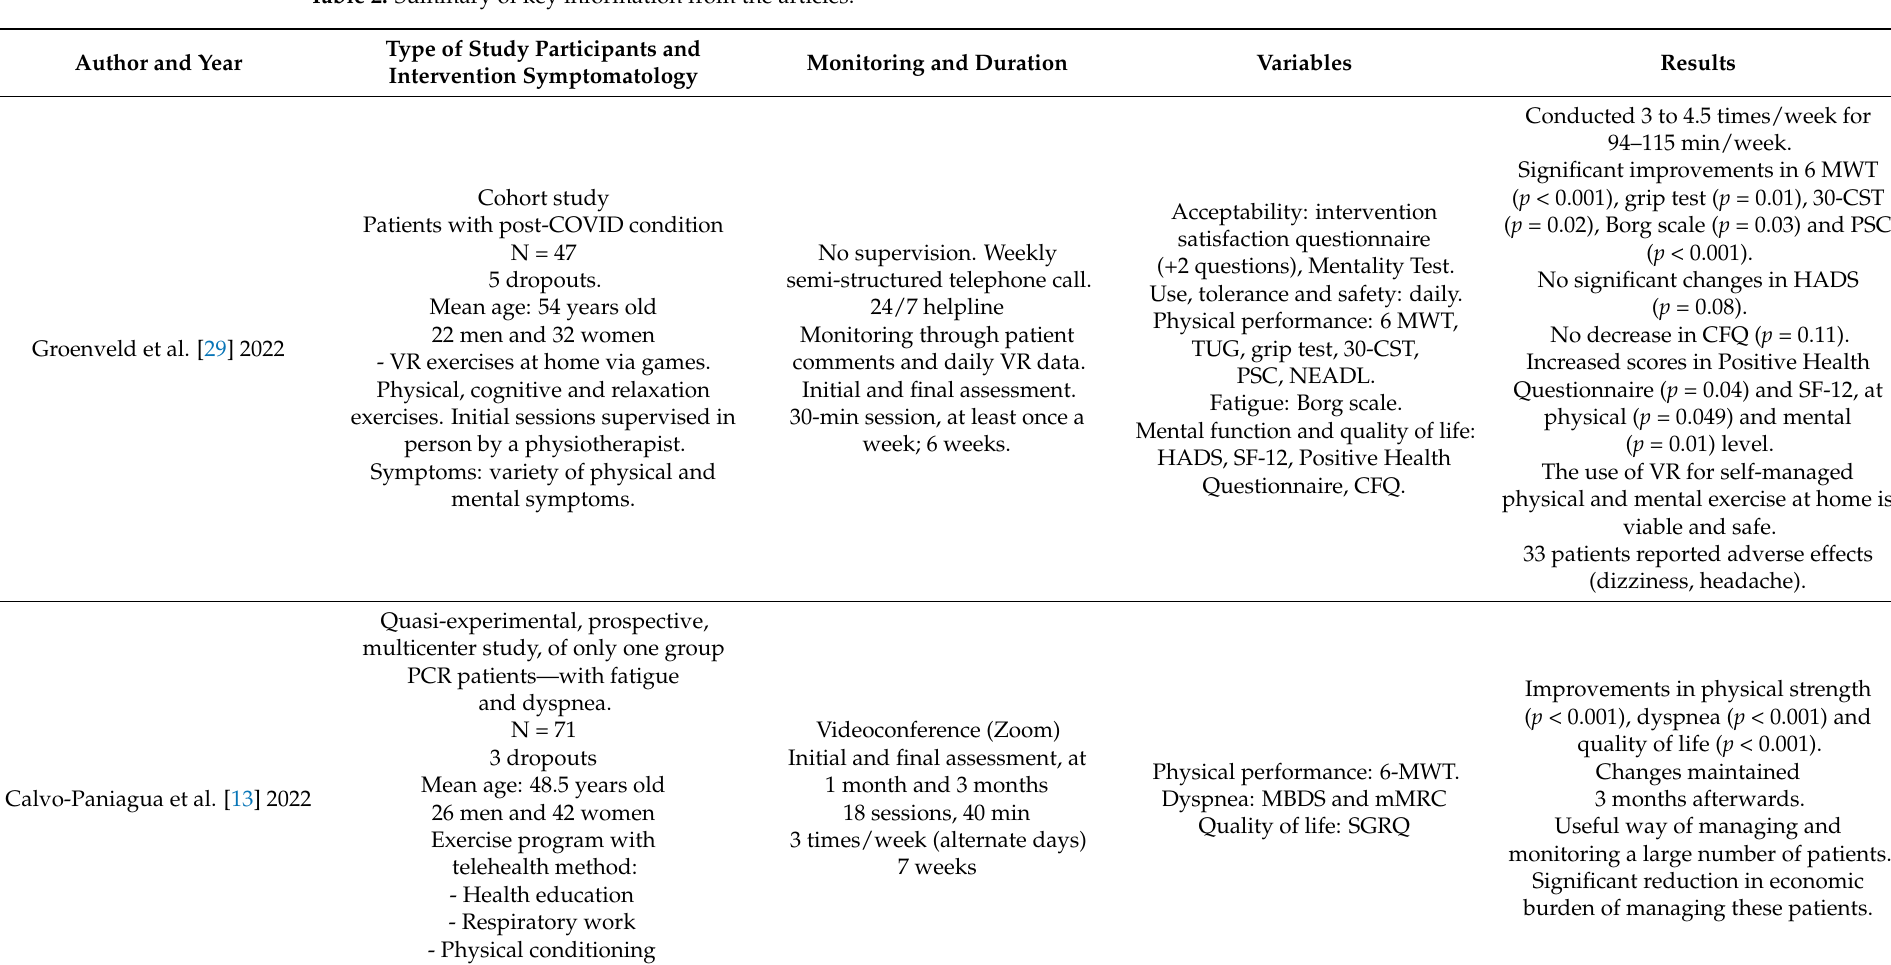
Table 2. Summary of key information from the